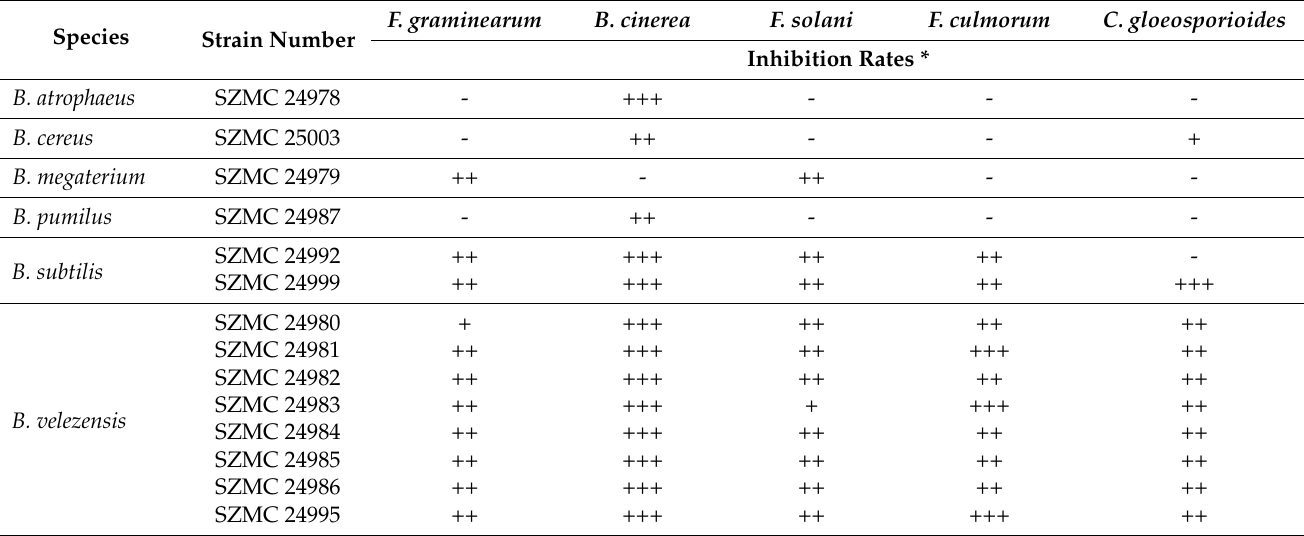
Table 4. Inhibition of bacterial pathogens by